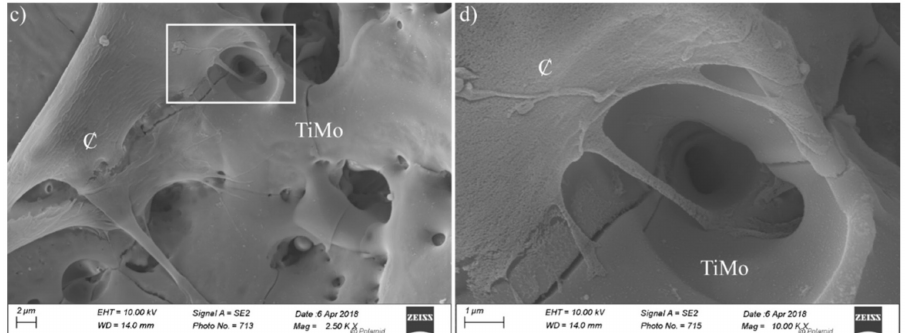
Figure 10. Typical SEM micrographs of osteoblasts grown on Ti SLA ( a , b ) higher magnification) and anodized Ti-15Mo ( c , d ) higher magnification) at day 4 (white square: magnified zone; : cell; Ti: uncovered Ti SLA; TiMo: anodized